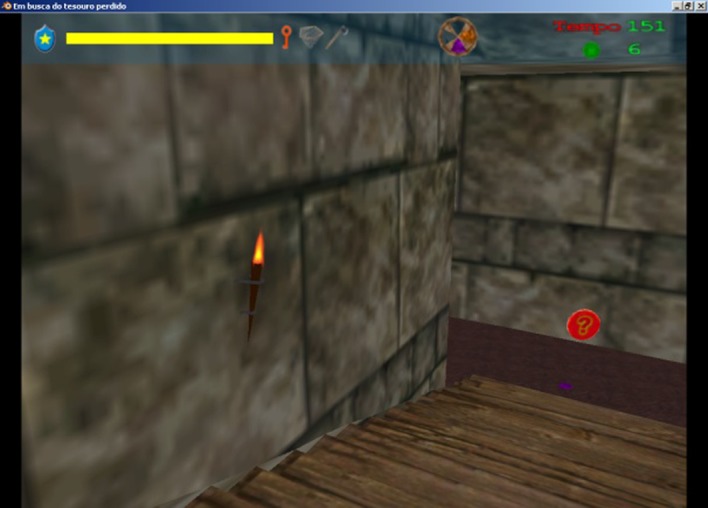
Internal Environment [6].